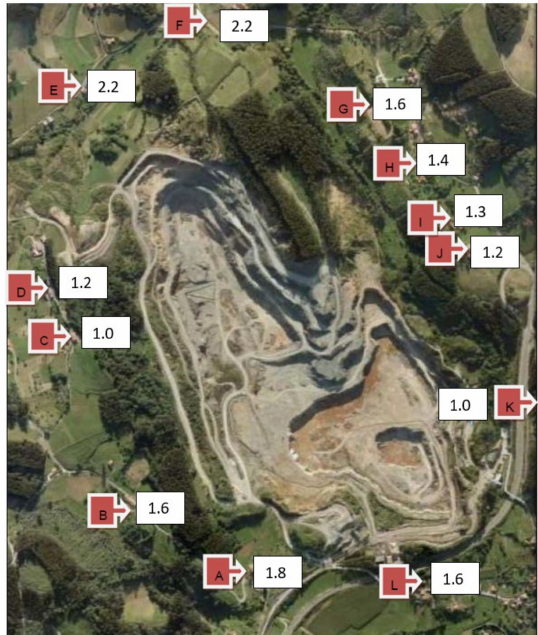
Figure 10. Differences between attenuation laws. Table 4. Characteristics of the validation blasts and PPV recorded and